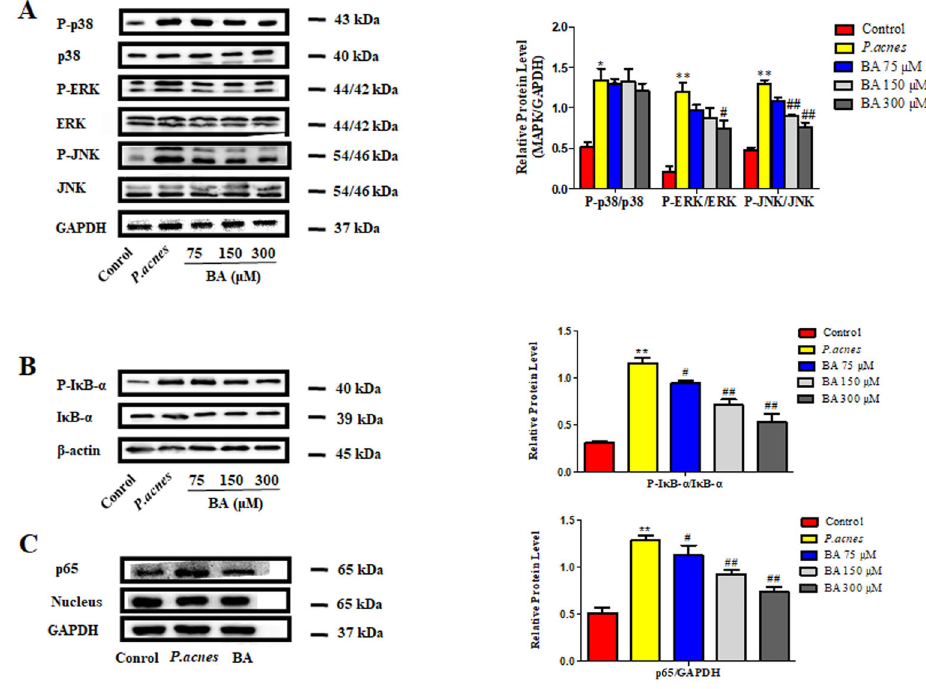
Figure 2. Effects of baicalin (BA) on the MAPK and NF- k B signaling pathways in P. acnes -stimulated THP-1 cells. THP-1 cells were pre- treated with different concentrations of BA (75, 150, 300 m M) for 24 h, and then stimulated with heat-killed P. acnes for a further 12 h. Total cell lysates and nuclear lysates were separated by gel electrophoresis and speci fi c proteins were measured by western blotting. A-C , Detection of phosphorylated ERK, JNK, p38, I k B a , and the NF- k B p65 nuclear translocation. The data are reported as means ± SE from at least three independent experiments. *P o 0.05, **P o 0.01 vs control; # P o 0.05, ## P o 0.01 vs P. acnes alone (ANOVA).